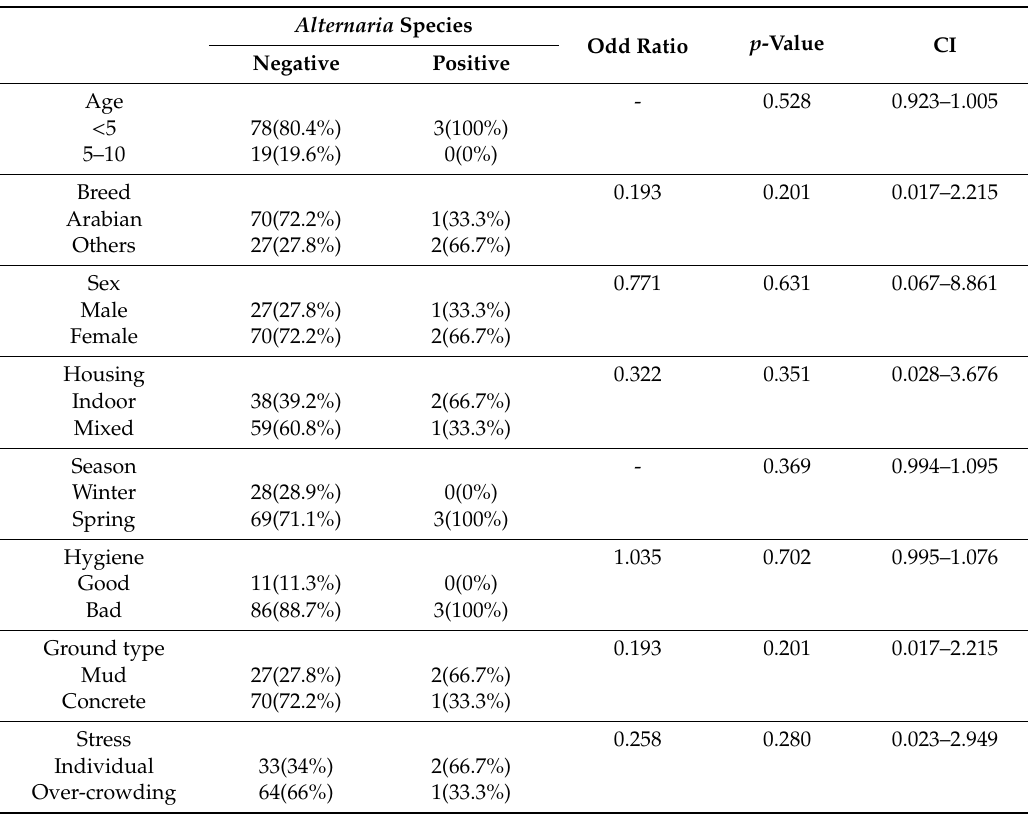
Table 8. Risk factors of